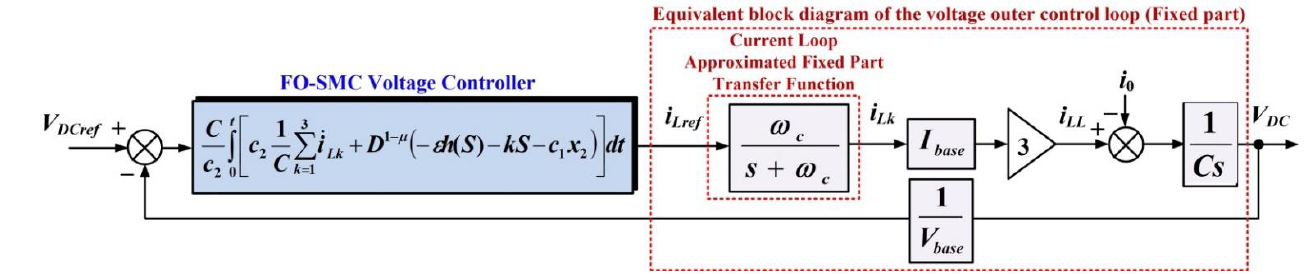
Figure 9. Block diagram modeled using a transfer function for the control system of the power elec- tronic converter using an FO SMC controller for the voltage outer control loop.